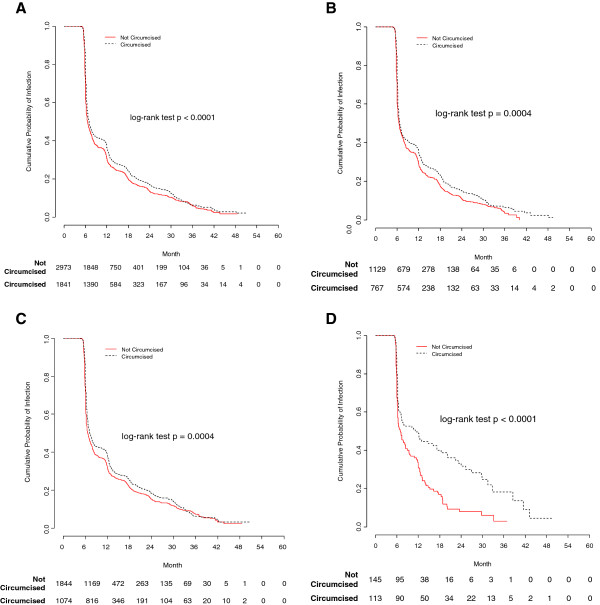
Kaplan-Meier estimates of time to clearance of human papillomavirus (HPV) incident infections. Kaplan-Meier estimates of time to clearance of human papillomavirus (HPV) incident infections for any HPV, oncogenic HPV, non-oncogenic HPV, and HPV 16 by male circumcision status: A) Clearance of any HPV; B) Clearance of oncogenic HPV; C) Clearance of non-oncogenic HPV; D) Clearance of HPV 16.